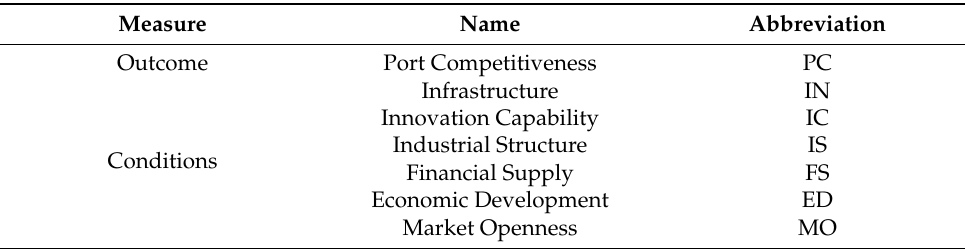
Table 1. Outcome and condition